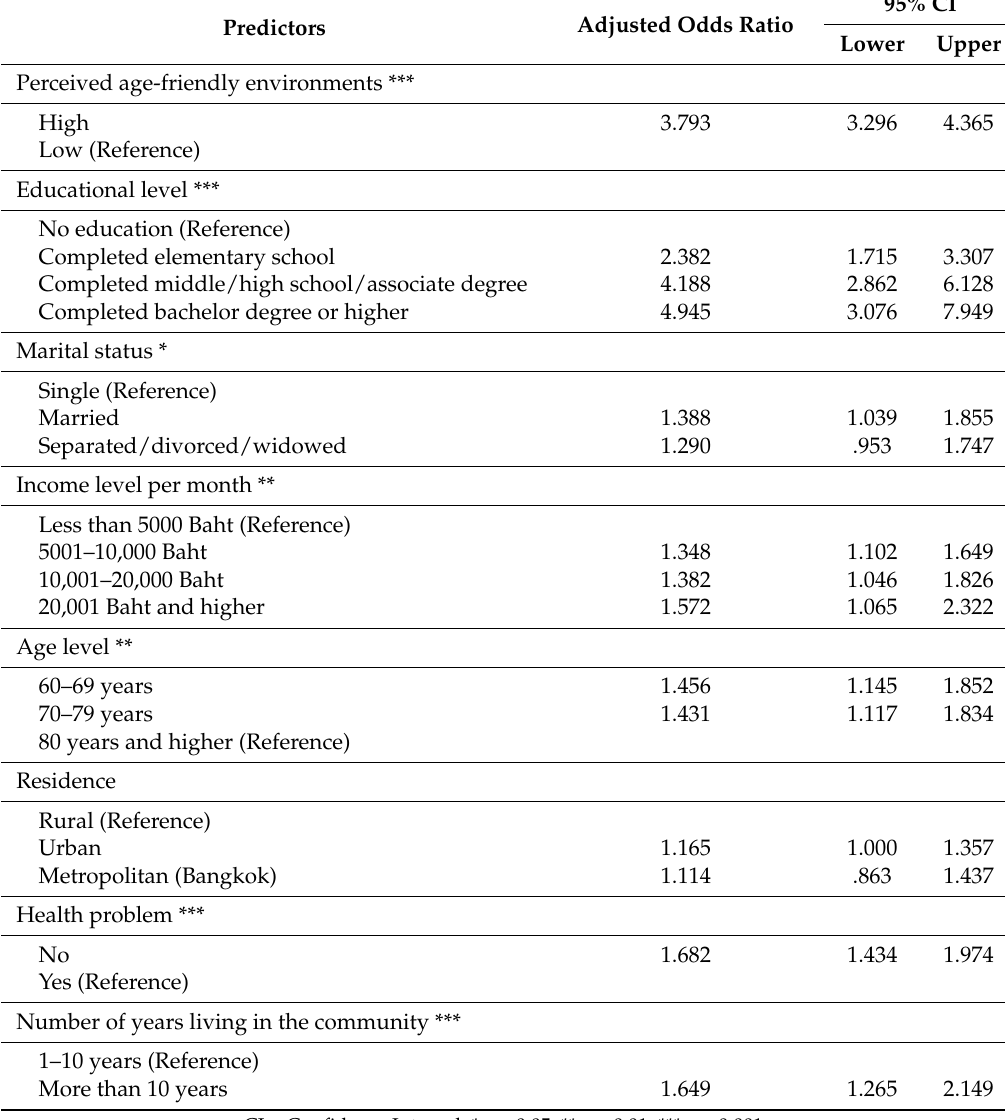
Table 4. Total age-friendly environments (physical, security, and social environments), socio-demographic factors and health conditions as predictors of quality of life among Thai older